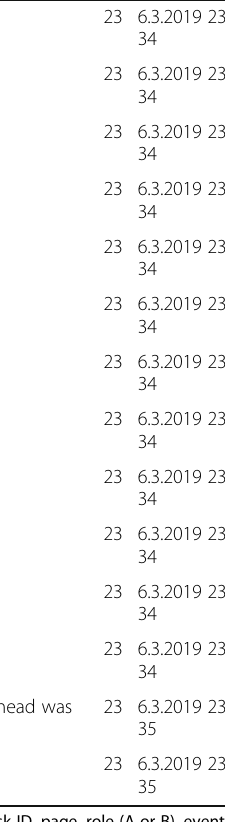
fifprr0048 103 1 A Action